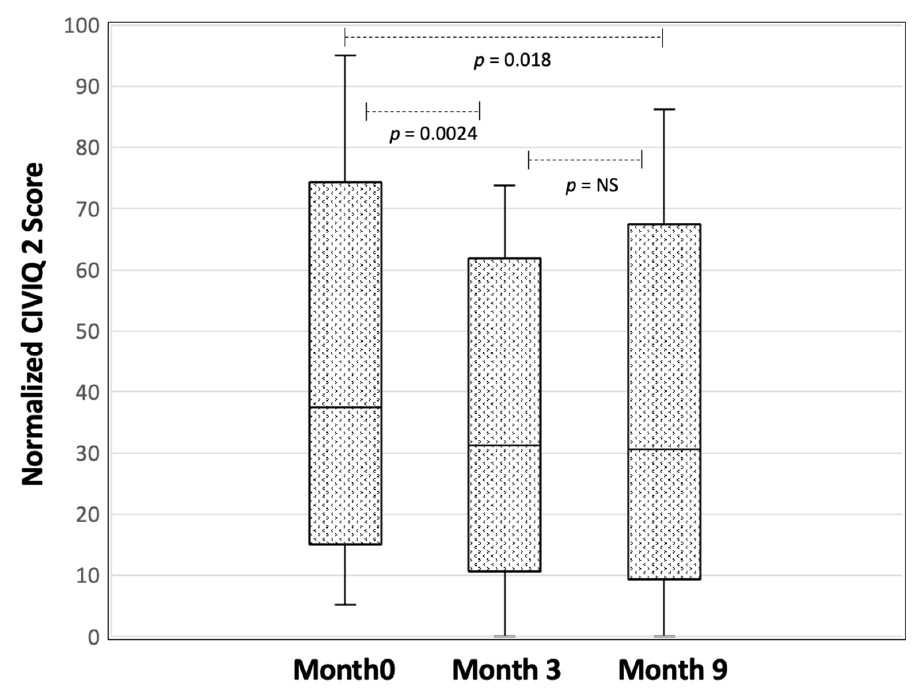
Figure 1. Evolution of normalized CIVIQ 2 score at months 3 and 9 after education course. A high score means a reduced quality of life.